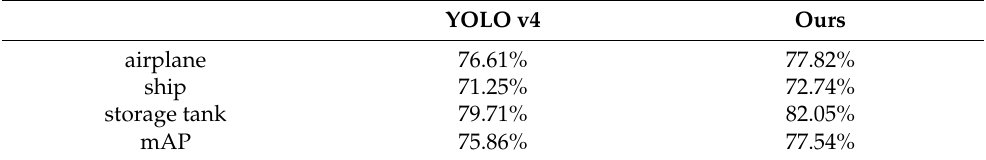
Table 4. Ablation experiment. SGPANet represents use SandGlass block. SGLPANet mean uses SandGlass-L block.IRA is the Inception ResNet-A.